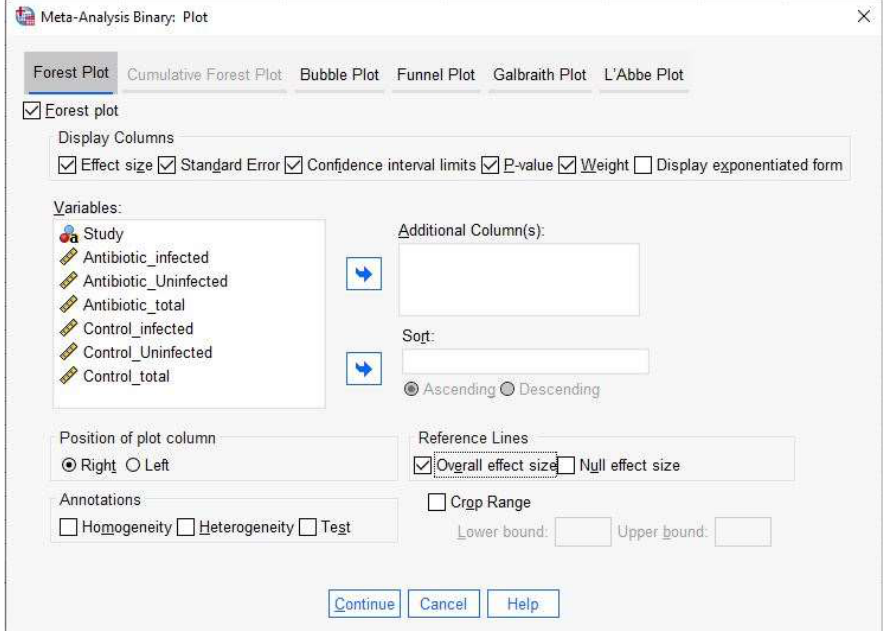
Figure 10. Forest Plot Menu. Figure 11.